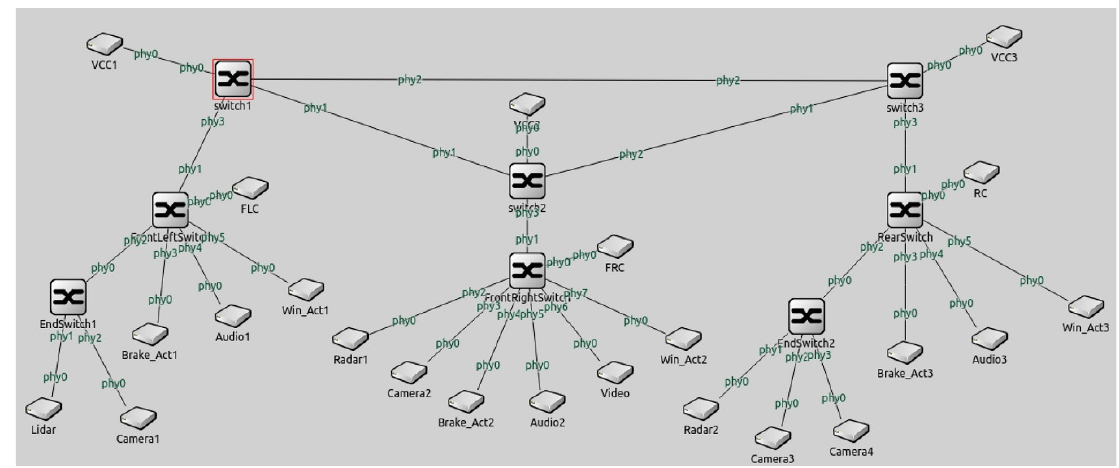
Figure 3. TSN topology in the simulation platform.